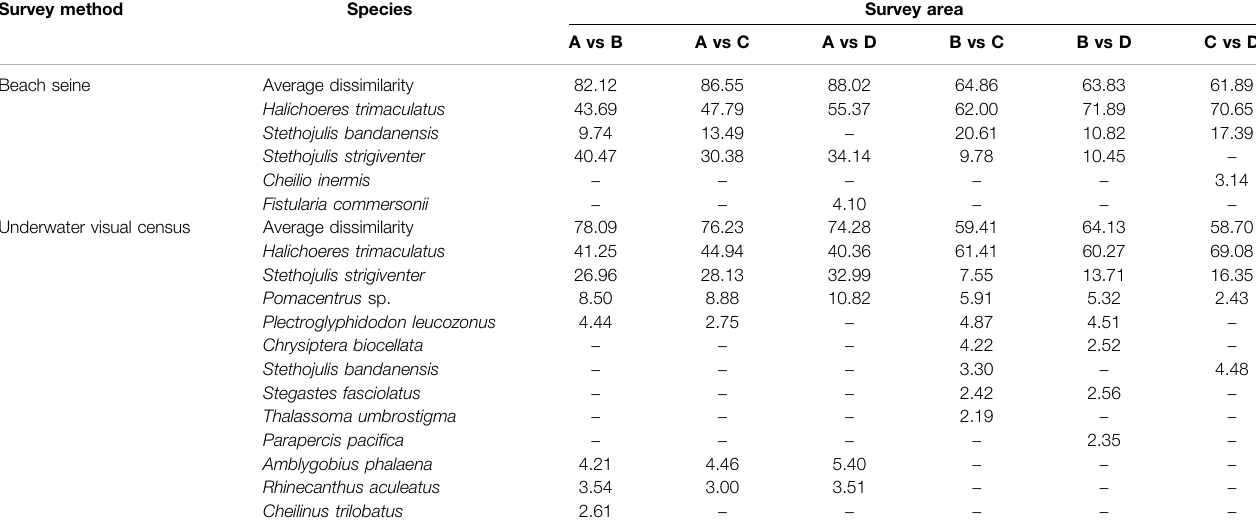
TABLE 2 | Contributory in fl uence of fi sh species on the dissimilarity between fi sh assemblages using BS and UVC methods (cumulated contribution > 90%). Survey method